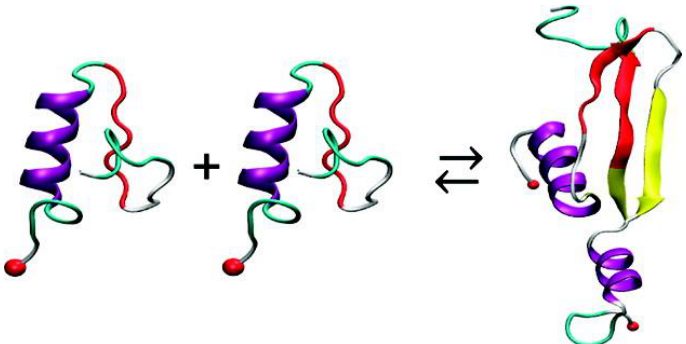
Figure 12. Dimerization of hIAPP with conversion of helix–coil to helix–β-strand structures (adapted from Dupuis et al. [98]. Copyright (2011) American Chemical Society.